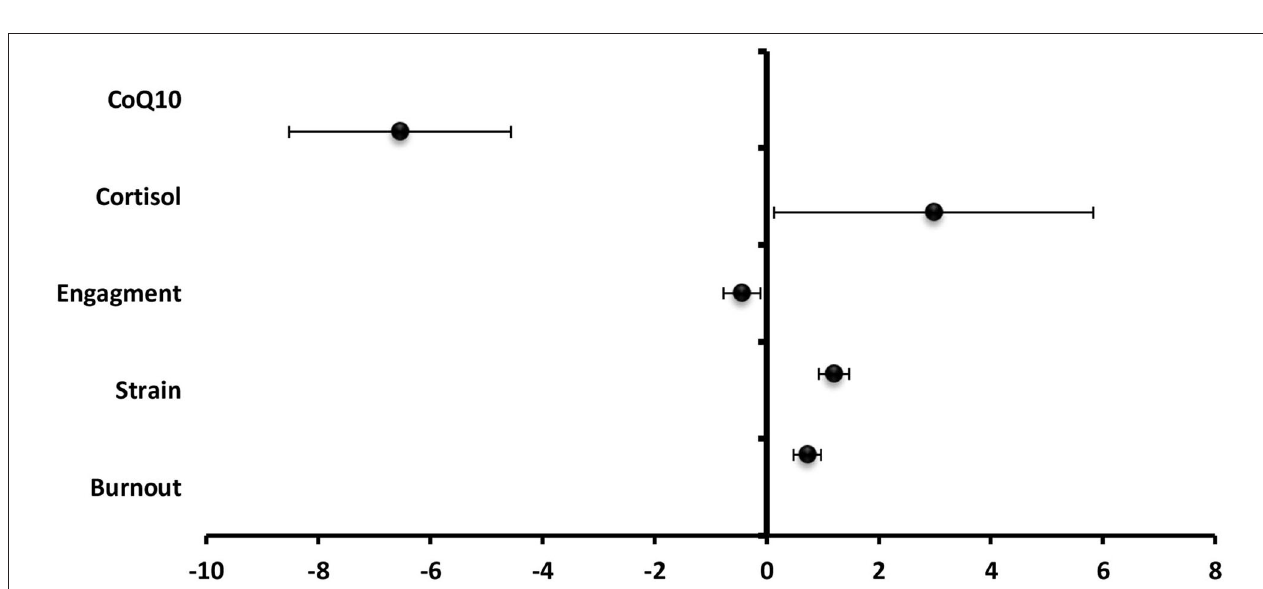
FIGURE 8 | Values of β and CI 95% for linear regression analysis of techno-stress items and job and technology characteristics as a predictor to engagement among students.